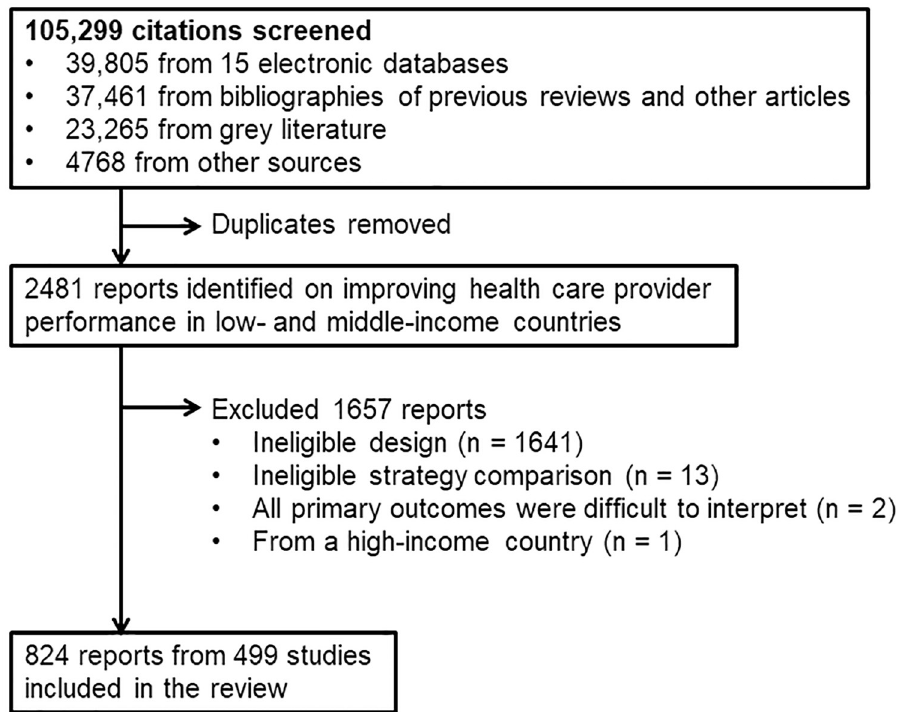
Fig 1. Summary flowchart of the literature